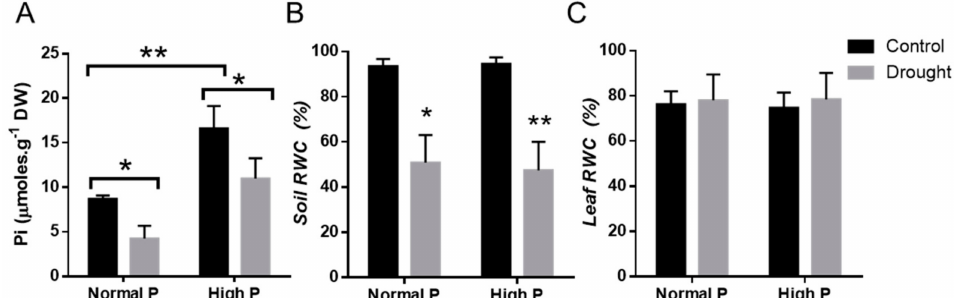
Figure 6. ( A ) Determination of inorganic phosphorus (Pi) concentration ( µ moles.g − 1 dry weight (DW)) in P. vulgaris leaves that were well-watered (control) and drought-stressed (drought) and cultivated with 80 µ M of KH 2 PO 4 (Normal P) or supplemented with 200 µ M of KH 2 PO 4 (High P) for one week before the water withholding treatment. ( B ) Soil relative water content. ( C ) Leaf relative water content measured in the 5th trifoliate leaves of control and drought-stressed plants of low or high P conditions. Data are means of three independent experiments. Asterisks indicate statistically significant di ff erences ( p < 0.05